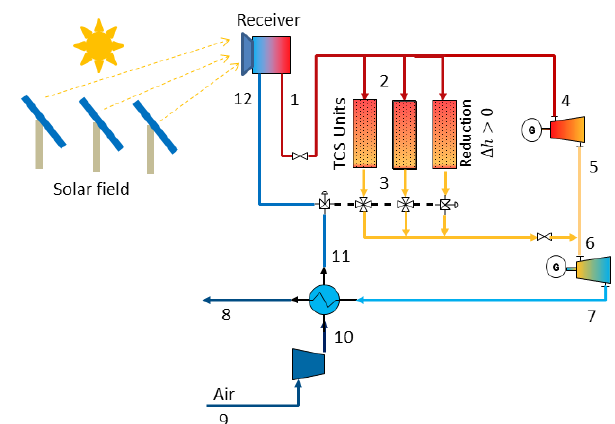
Figure 10. Integration scheme for a solar tower plant/ thermochemical storage (TCS) unit (oxide systems)/power block; on-sun operation.